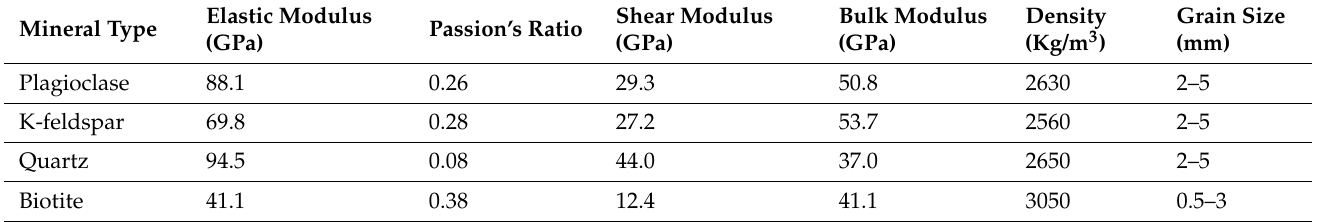
Table 2. Mechanical properties of the minerals.